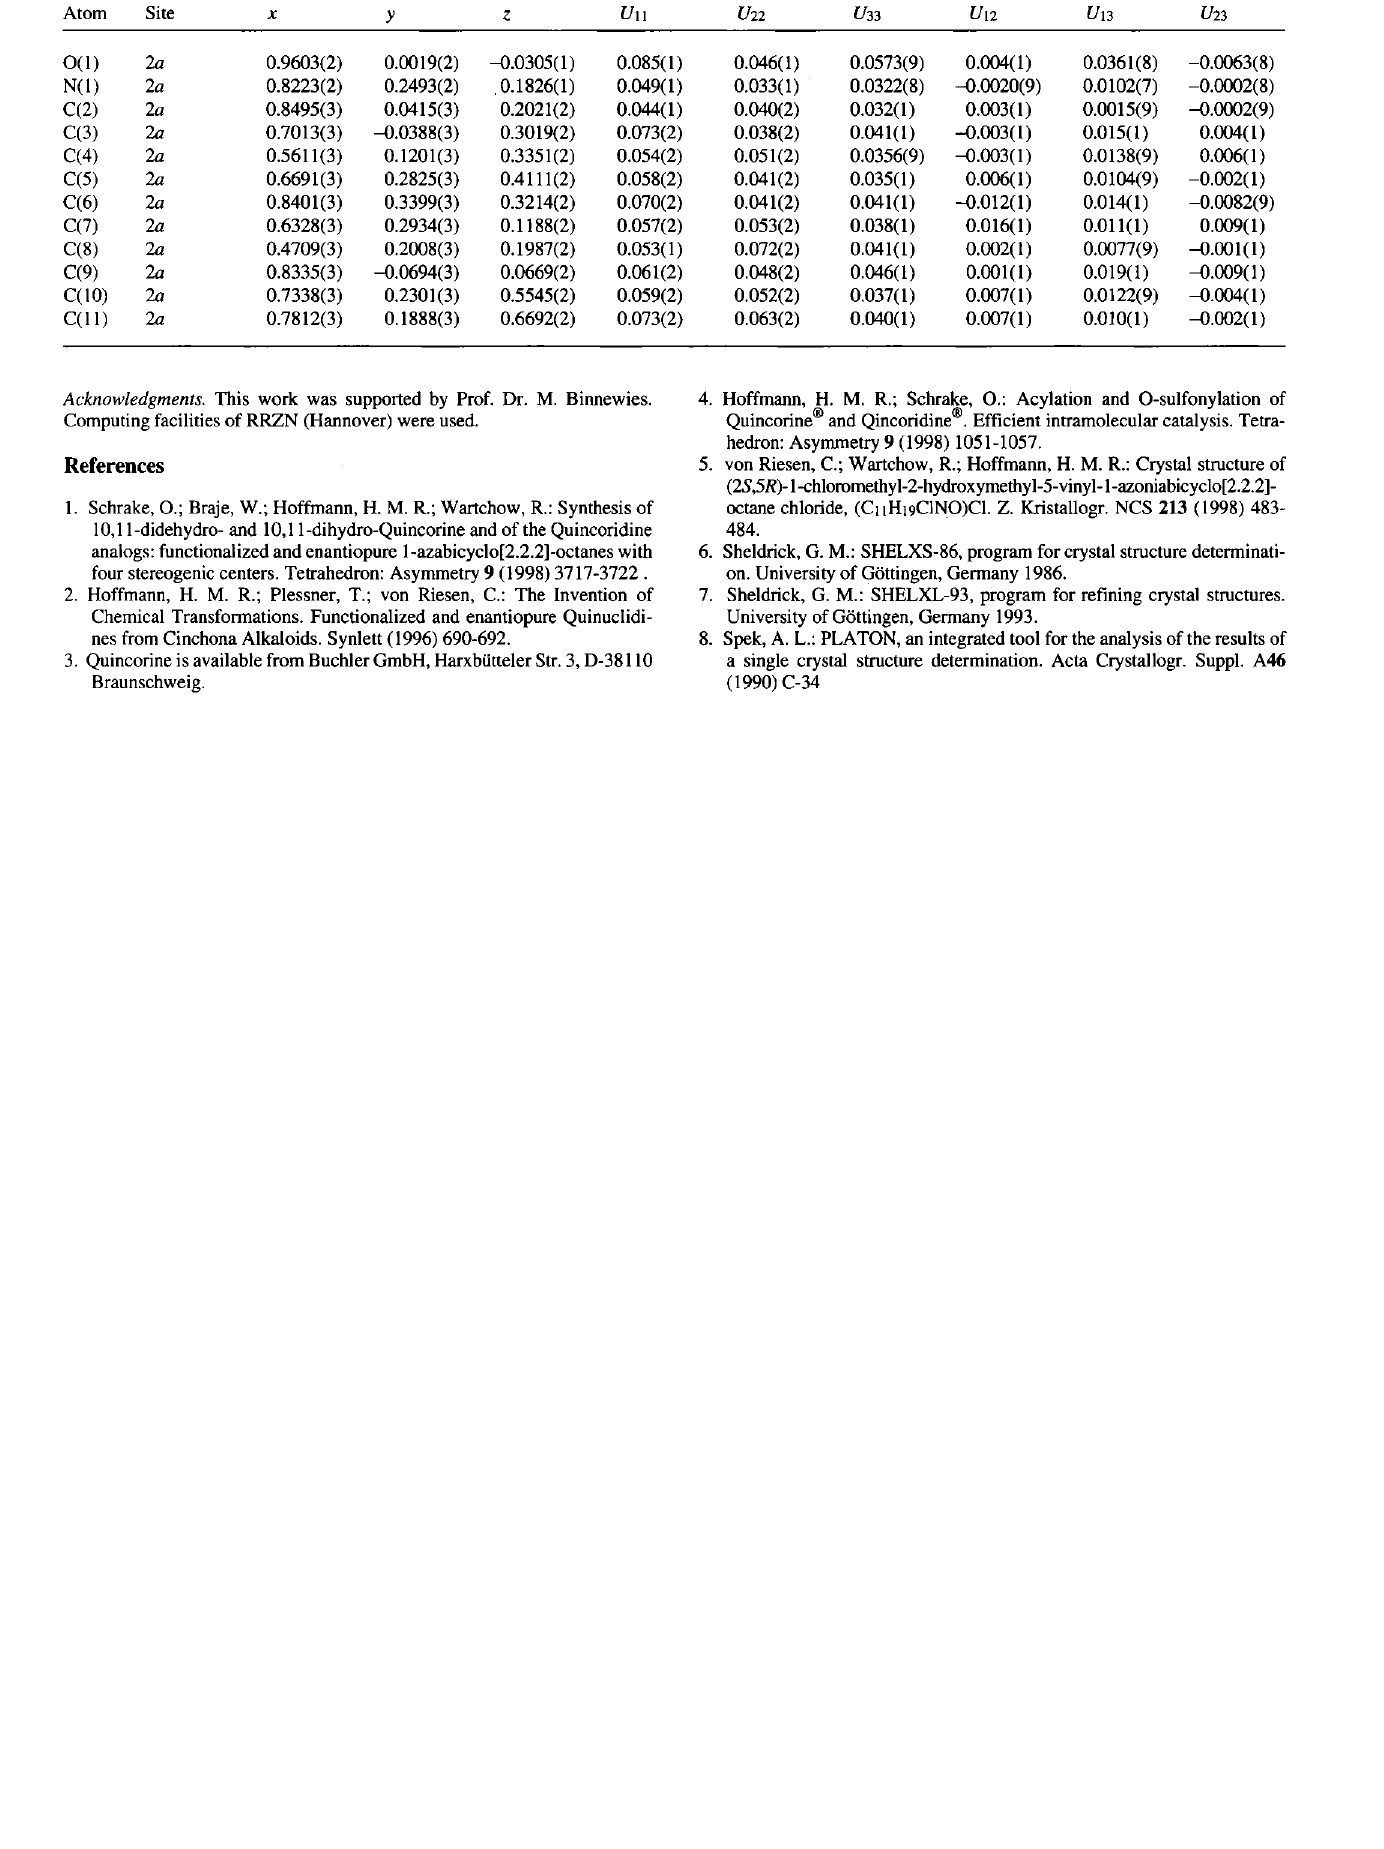
Table 3. Atomic coordinates and displacement parameters (in Ä 2